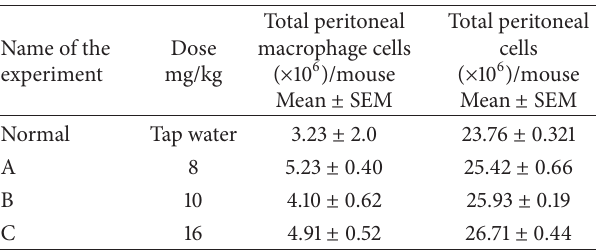
Table 9: The effect of test compounds on the enhancement of peritoneal cells and macrophages of life.